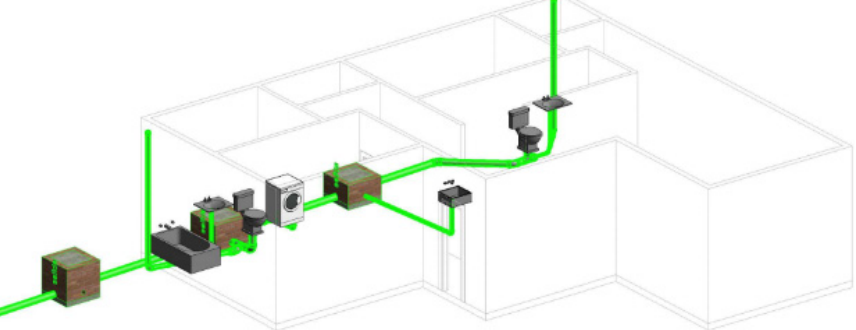
Figure 15. Household drainage network layout in a single-family house.